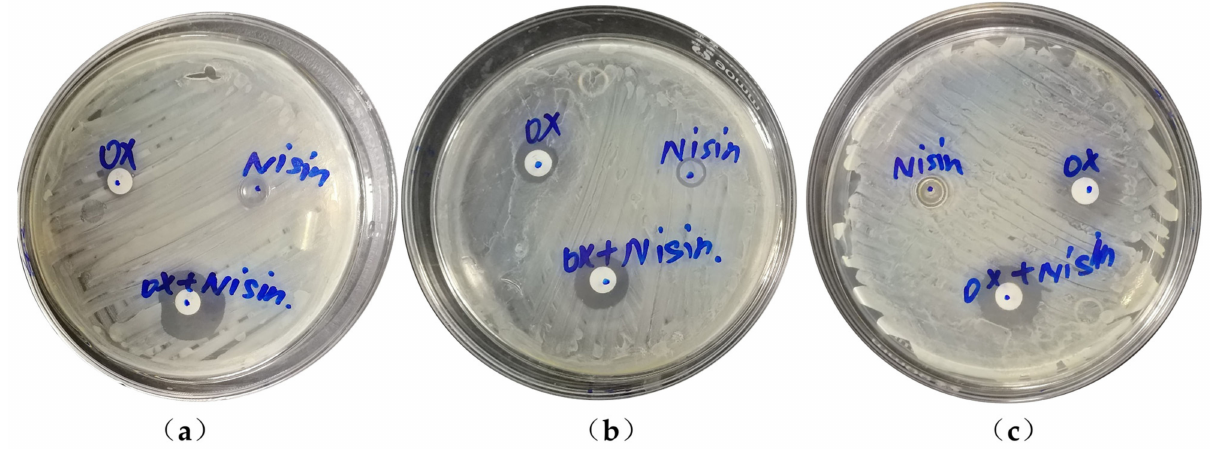
Figure 1. The change of inhibition zone of MRSA treated with OX, NIS and OX + NIS. ( a ) Yn2020043; ( b ) Yn2020051; ( c )